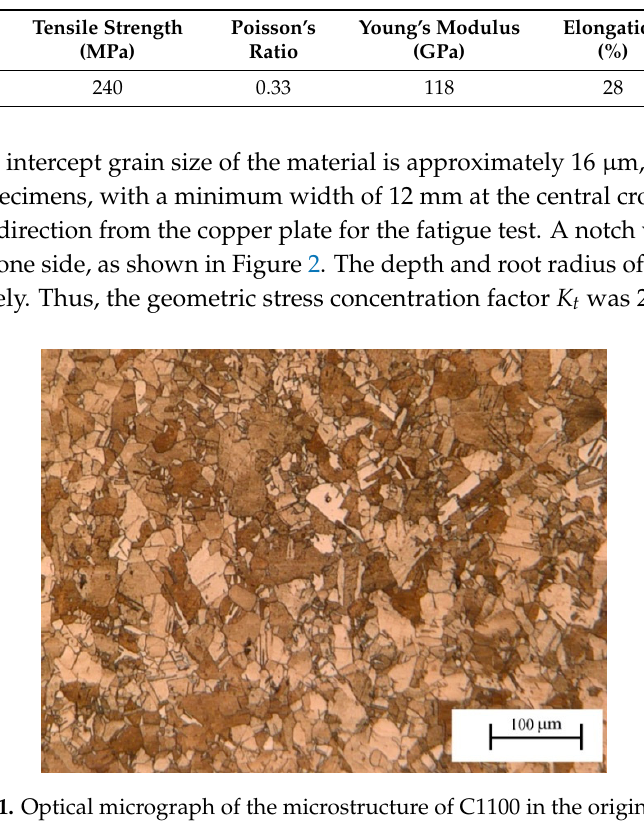
Table 1. Mechanical properties of C1100.